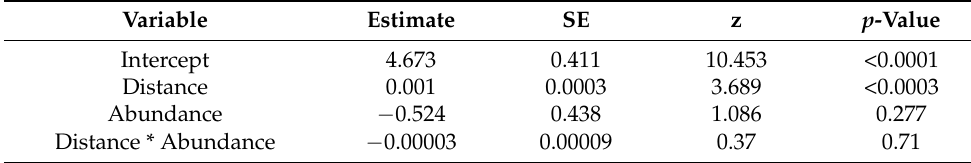
Table 2. The model-averaged coefficients and standard errors (SE) of the variables included in the best models that described the recolonisation time of the Feral Pigeons (i.e., AICc < 2). The asterisk (*) represents the